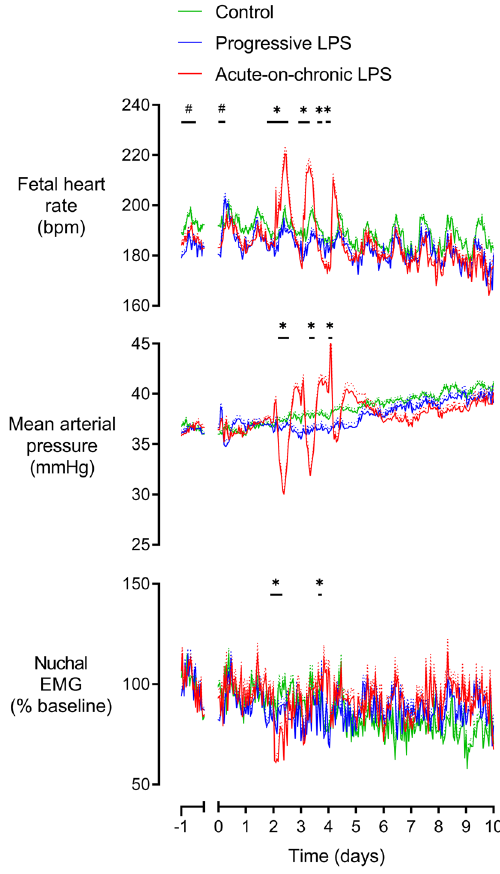
Figure 2. Changes in mean arterial pressure, fetal heart rate and nuchal electromyographic (EMG) activity during and after LPS infusions. Nuchal EMG activity is shown relative to baseline. All LPS infusions were started on day 0 and continued for a total of 5 days, fetuses were studied for a further 5 days after the end of infusions. Groups shown are control (green, n = 10), progressive LPS (blue, n = 8) and acute-on-chronic LPS (red, n = 9). Data are shown as 1 h mean ± SEM (mean is displayed as solid lines, SEM is displayed as dotted lines). Baseline FHR was included as a covariate. *P < 0.05 control vs. acute-on-chronic LPS, # P < 0.05 control versus progressive